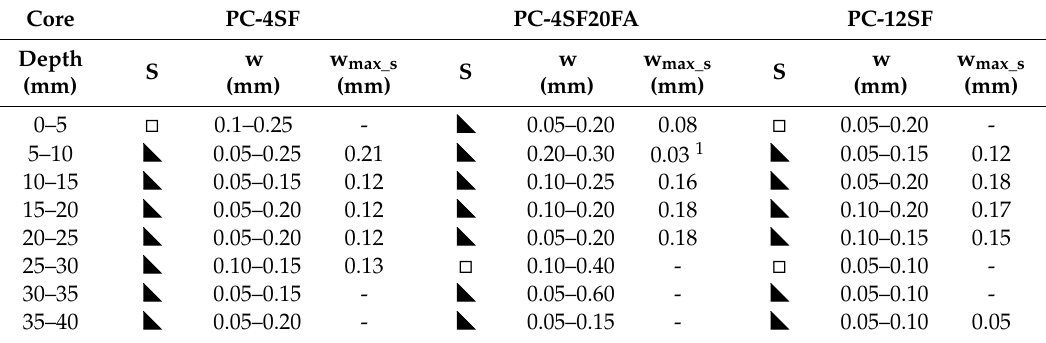
Table 7. Crack width (w) and degree of self-healing (S) of cracks and the maximum crack width to be completely closed (wmax_s) in PC-4SF, PC-4SF20FA and PC-12SF.